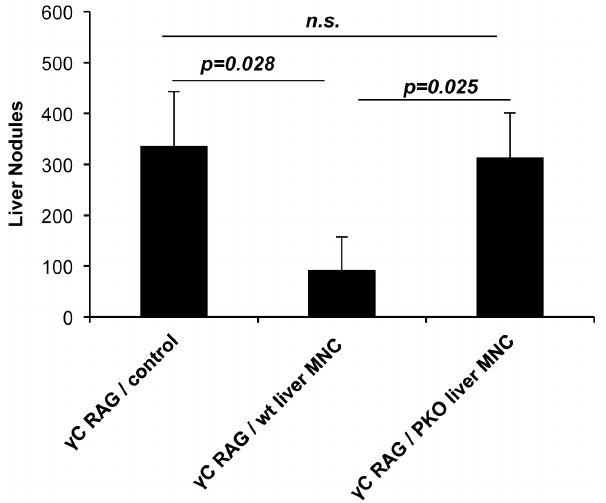
Figure 8. Liver mononuclear cells from perforin deficient mice do not confer protection from liver tumor colonization in NK cell deficient recipients. c c/RAG 2 KO mice or wild type control mice were injected intravenously with 1 6 10 6 liver MNC from wild type or perforin deficient C57BL/6 mice. Four days later, recipients were inoculated intravenously with 2 6 10 5 B16F1 melanoma cells. Fourteen days later livers were excised and tumors nodules were enumerated.